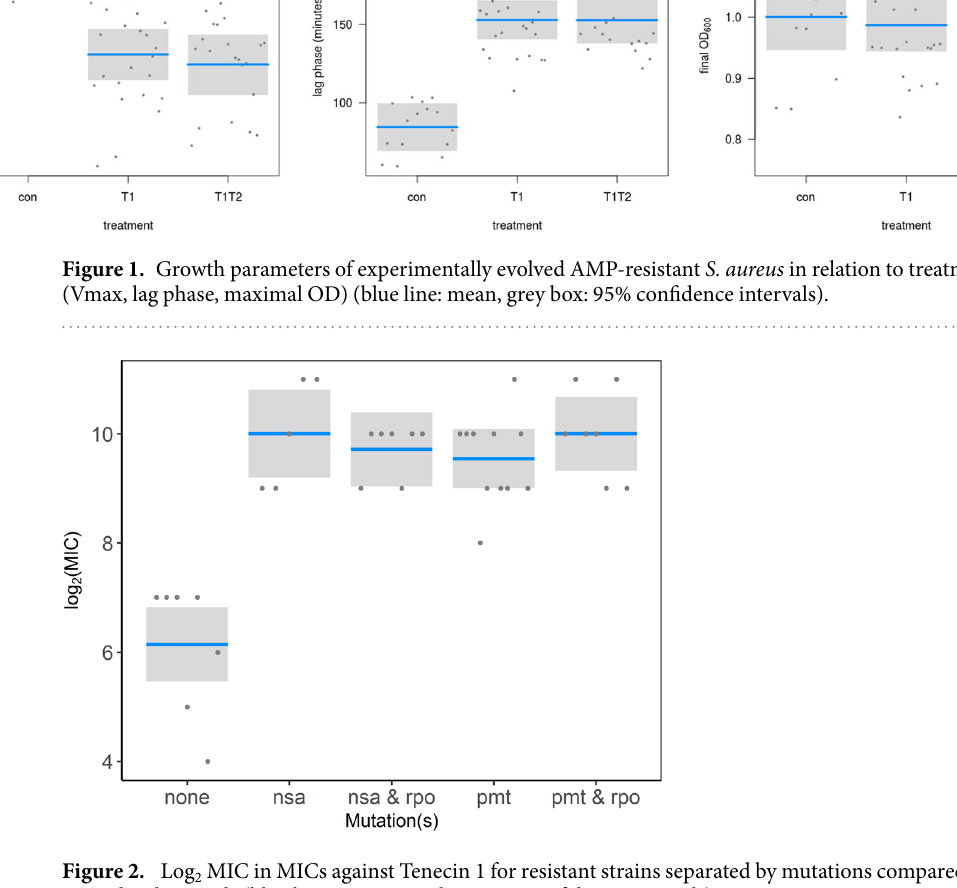
Figure 2. Log 2 MIC in MICs against Tenecin 1 for resistant strains separated by mutations compared to procedural controls (blue line: mean, grey box: 95% confidence